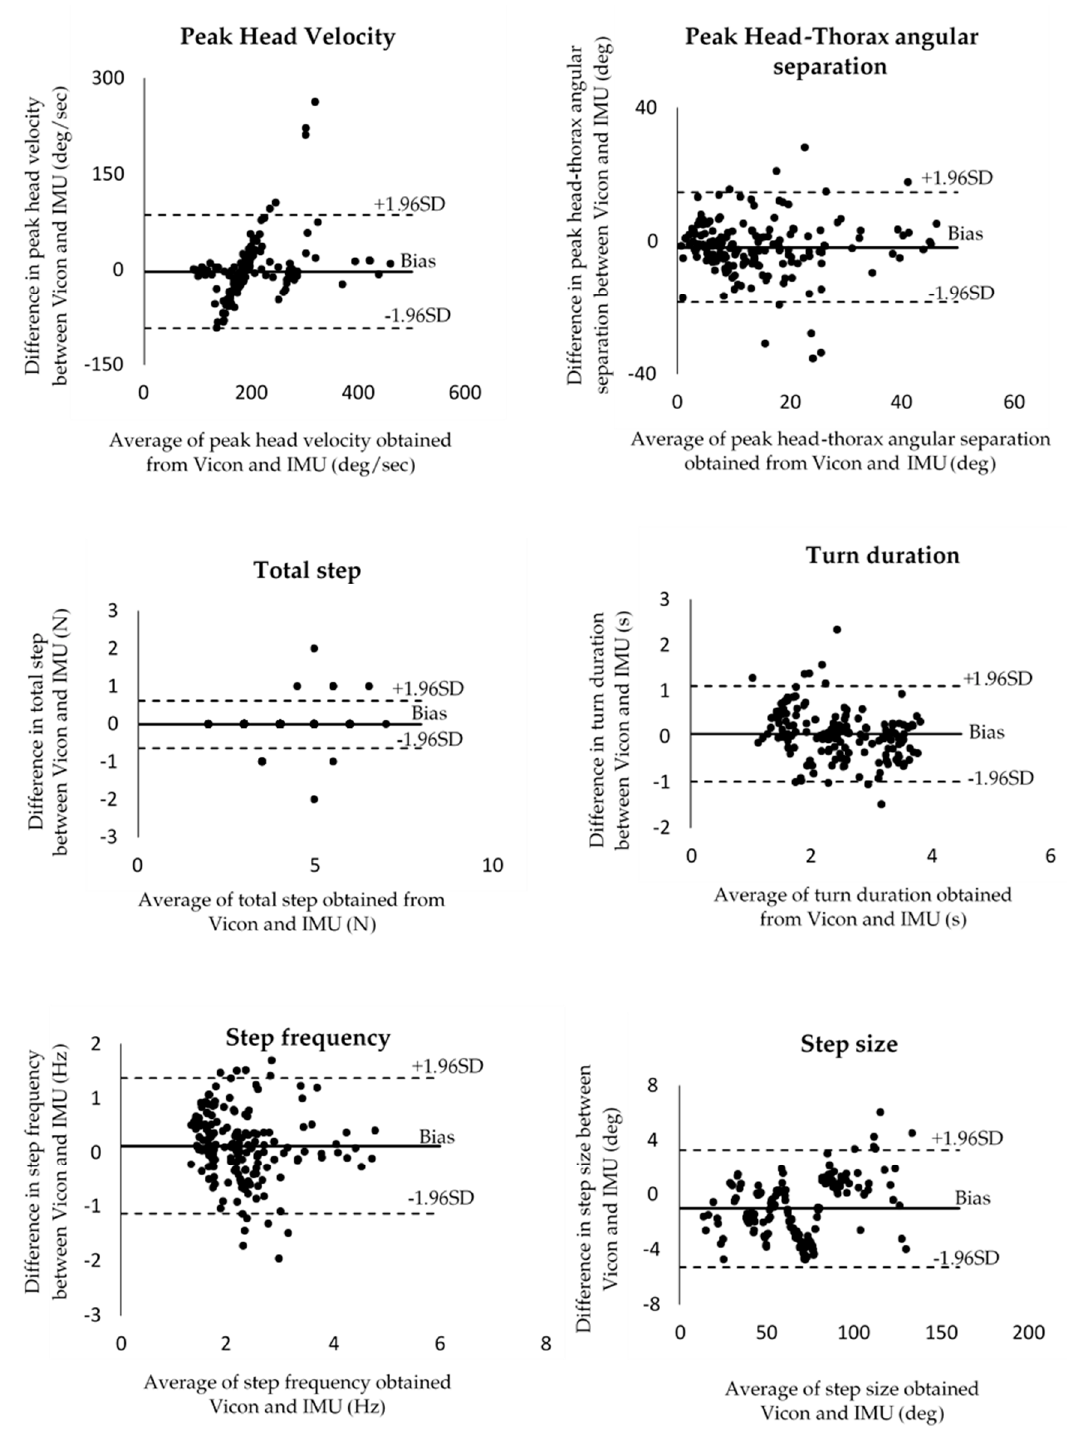
Figure 3. Bland–Altman plots for all variables. Solid line systematic bias (mean); dash lines limits of agreement.